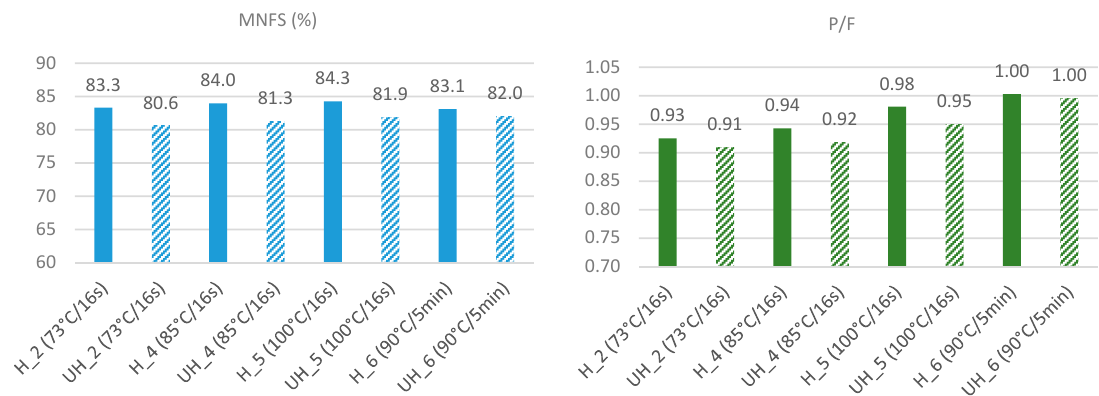
Figure 1. Moisture on non-fat substances (MNFS, %) and protein-to-fat ratio (P/F) of Quark-type cheeses made from homogenized (H) and unhomogenized (UH) milk heat-treated under different conditions.